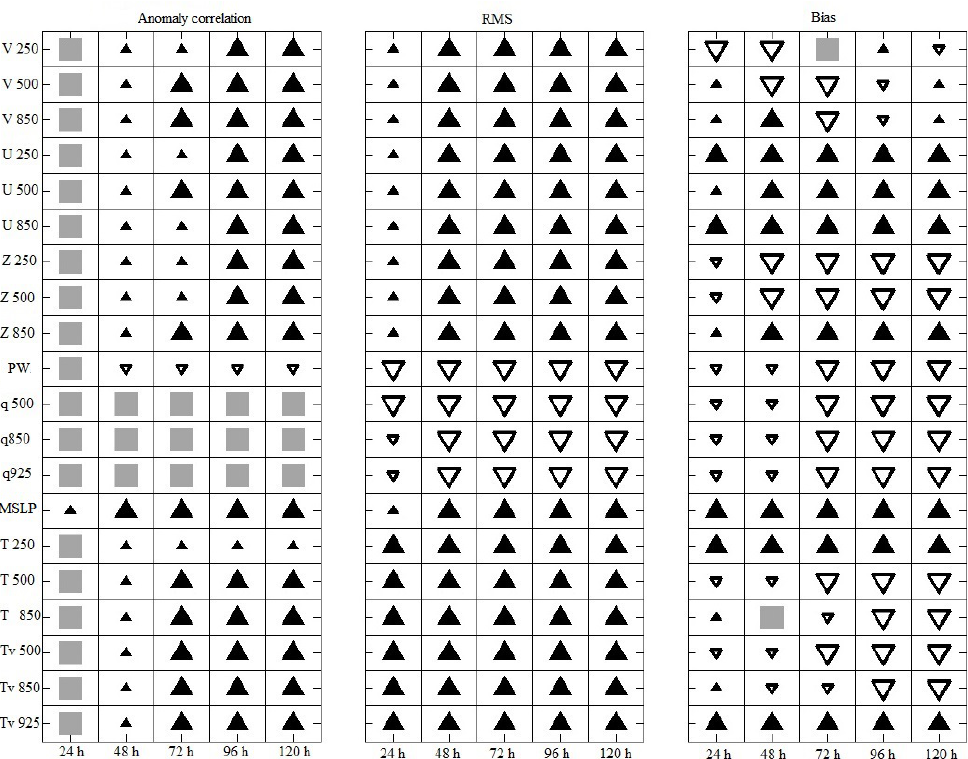
Figure 5. In this study we show the summary impact of RMS, bias and anomaly correlation coefficient values between PRH and NRH experiments and the global domain in all variables. The black triangles indicate that the PRH experiment was better than the NRH experiment and a white triangle represents the opposite. The triangle sizes indicate statistical significance of the metrics (small is less significant, and vice versa). The ash squares show that the values between the initial conditions and the forecasts are not statistically